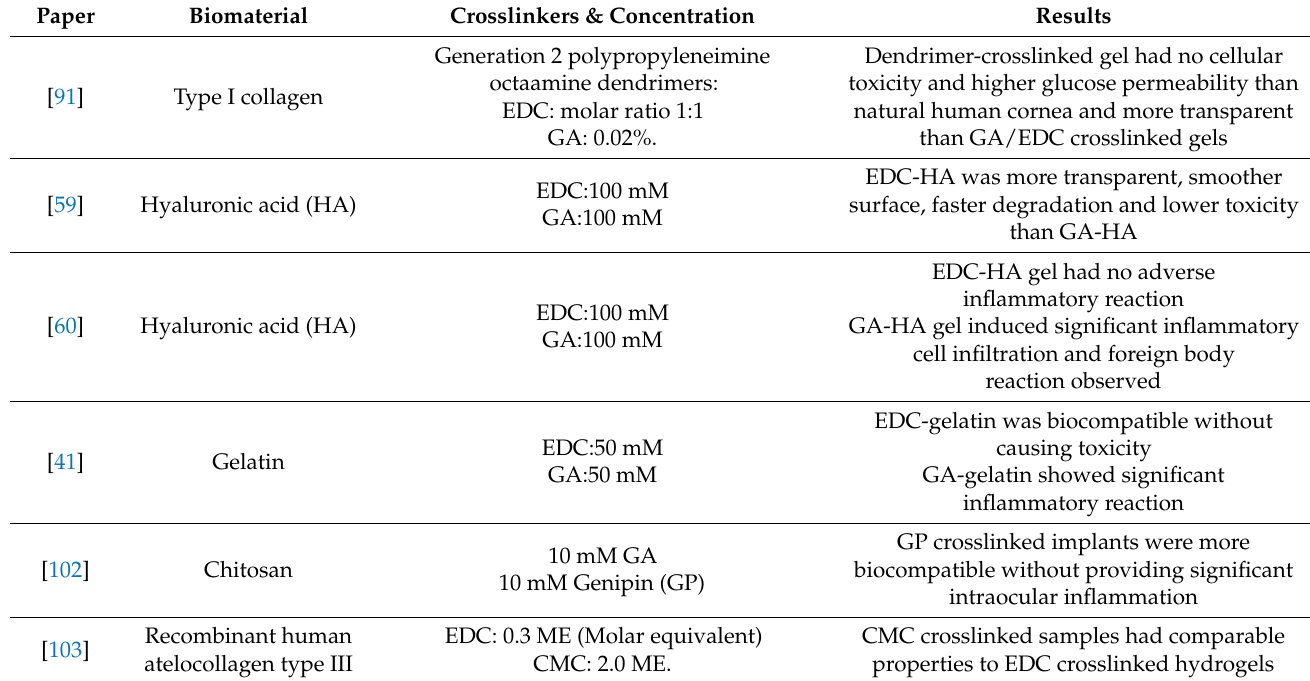
Table 2. Works identified in this review focusing on the comparison of different crosslinkers used to develop corneal hydrogels.